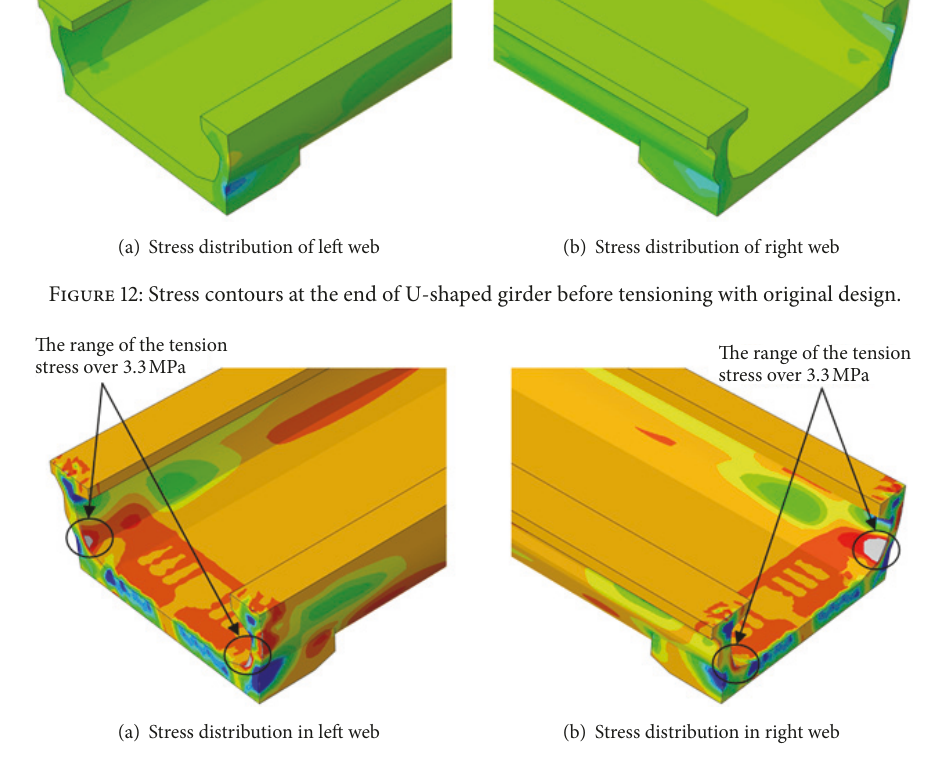
Figure 13: Stress contours at the end of U-shaped girder after tensioning, with original